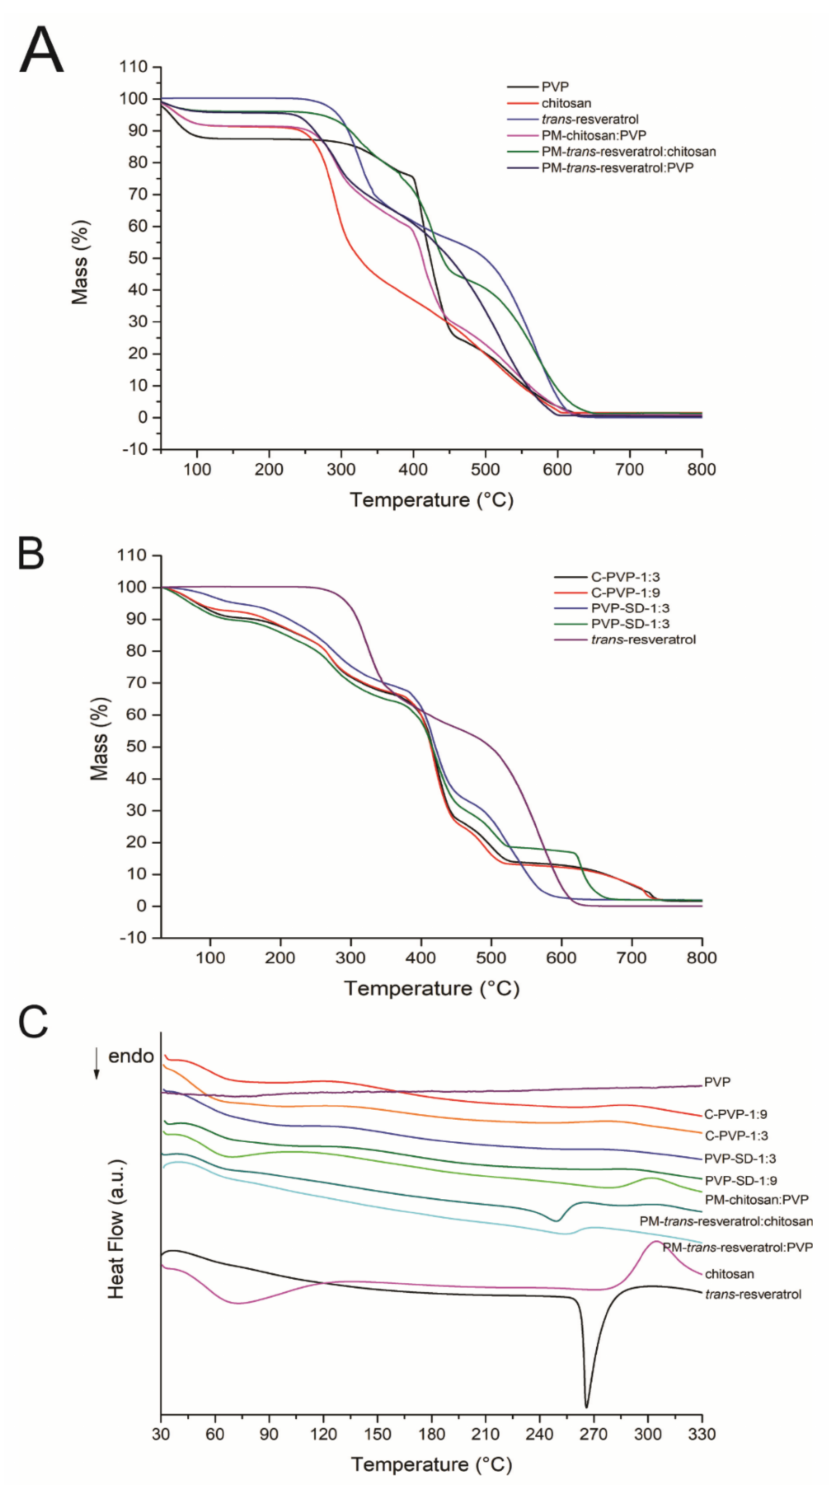
Figure 3. TG ( A , B ) and DSC ( C ) thermograms of the raw materials, physical mixtures (PM), and